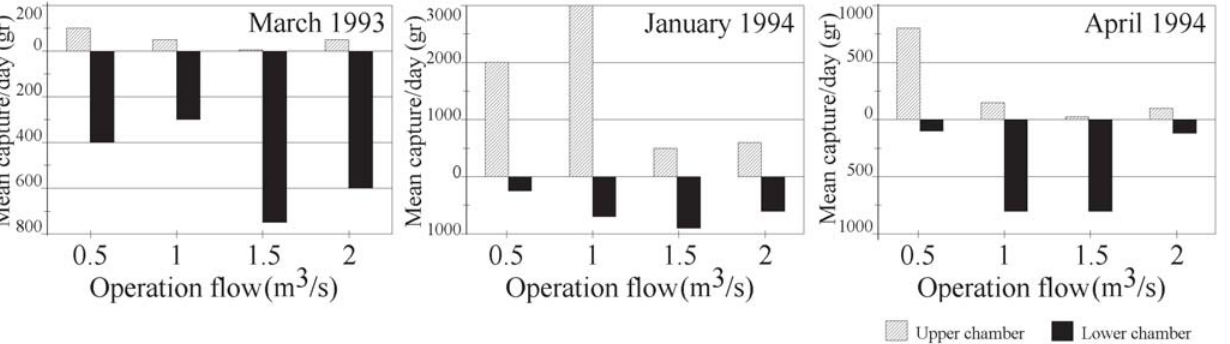
Fig. 9. Comparison between fish biomass in the upper and lower chambers across different operation flows over three different months (adapted from Espinach Ros et al., 1997).